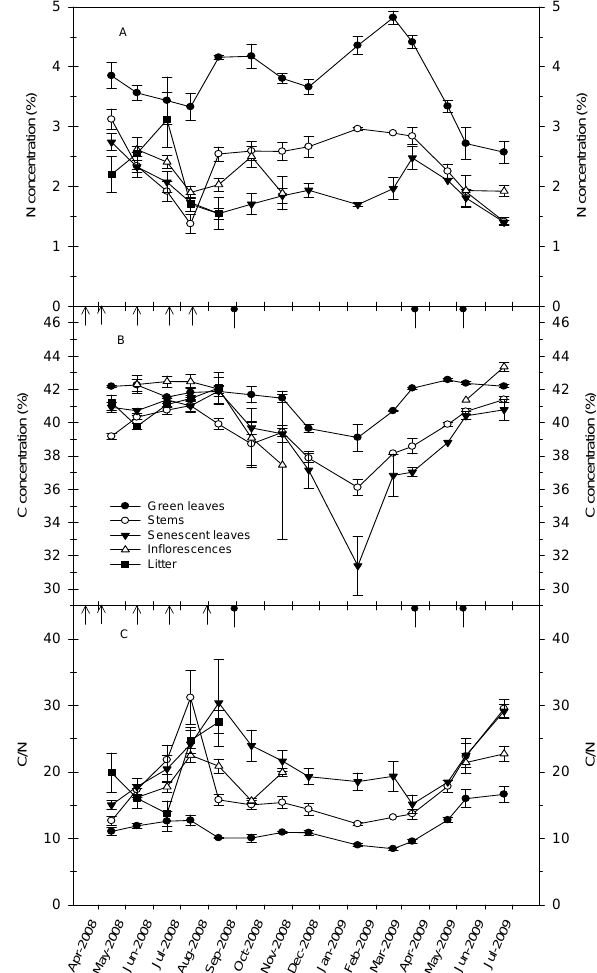
Fig. 4. Seasonal variation in total N concentration (A) , total C con- centration (B) and C/N ratio (C) per unit dry matter of different tissues of ryegrass. Arrows below the X-axis represent N applica- tion as NH 4 NO 3 ; the bar with solid circle represents N application as urea. peak value around − 27.5‰ was reached in summer 2008. Thereafter δ 13 C gradually decreased to a more negative value ( − 30 to − 32‰) which lasted until early spring 2009 when δ 13 C increased again. Green leaves had more negative δ 13 C values than the other tissues. The seasonal pattern of δ 15 N varied oppositely to that of δ 13 C, i.e. with a decrease dur- ing spring in both years and an increase during autumn and winter. In periods with intensive N application (April-July of both years), the δ 15 N values declined in all tissues and green leaves obtained a similar δ 15 N value as senescent leaves (Fig.